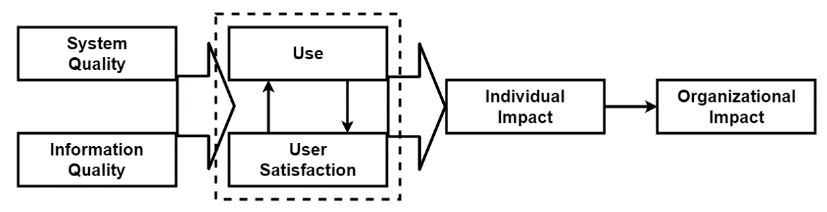
Figure 1. Information System Success Model [32].